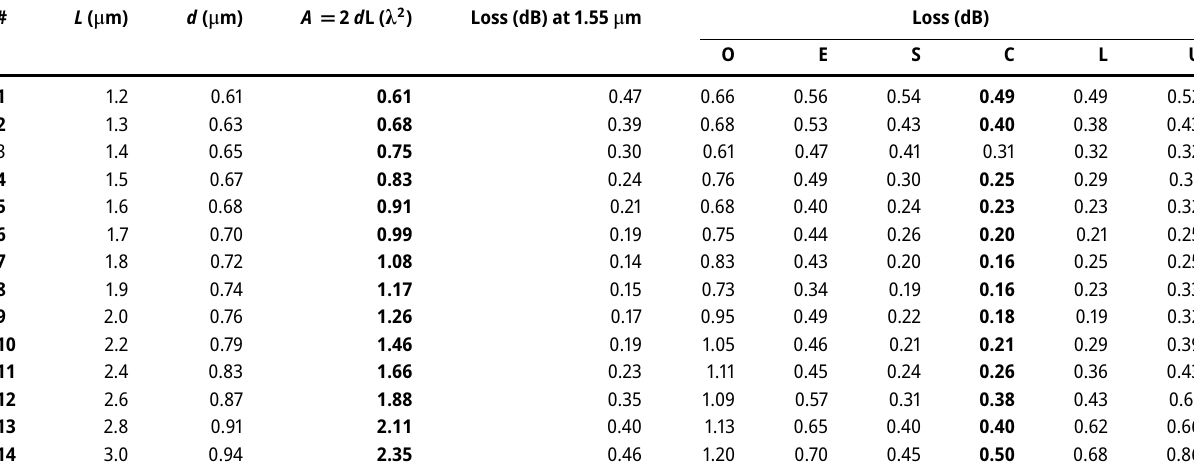
Table 5: The maximum losses of devices in Table 2 for various telecommunication